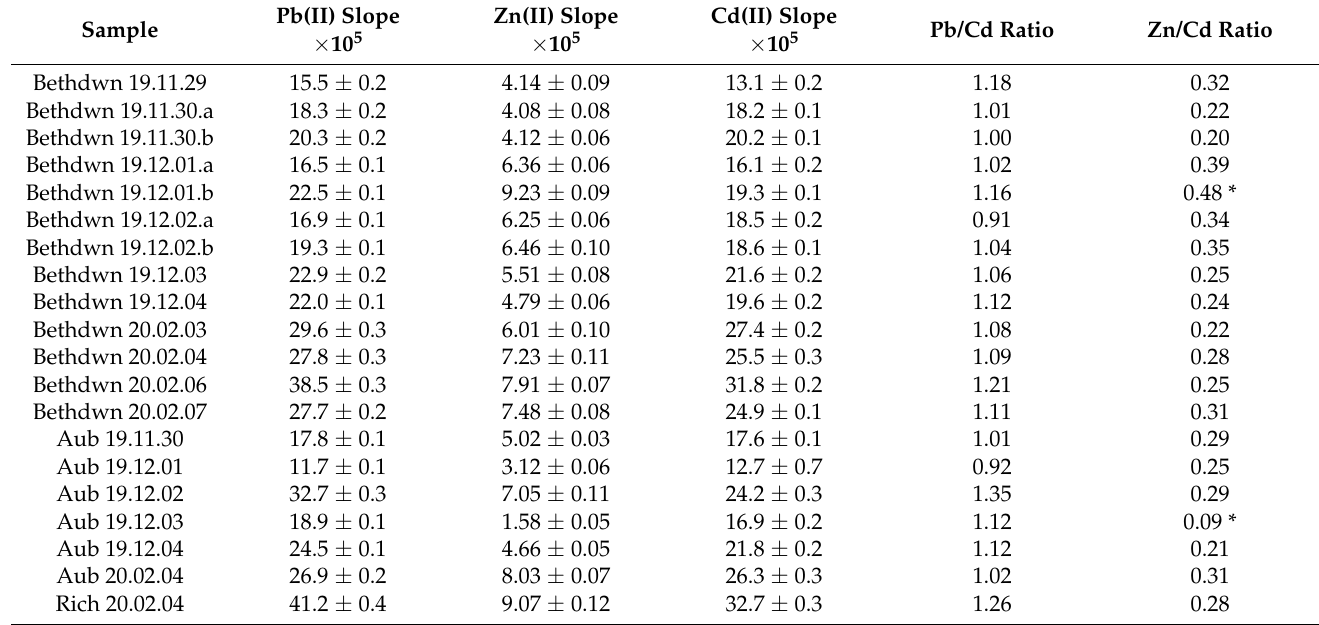
Table 4. SCP standard addition slopes and standard errors (deposition time of 90 s for Pb(II), Zn(II) and Cd(II)) in river samples and their ratios at natural ionic strength (acidified to pH